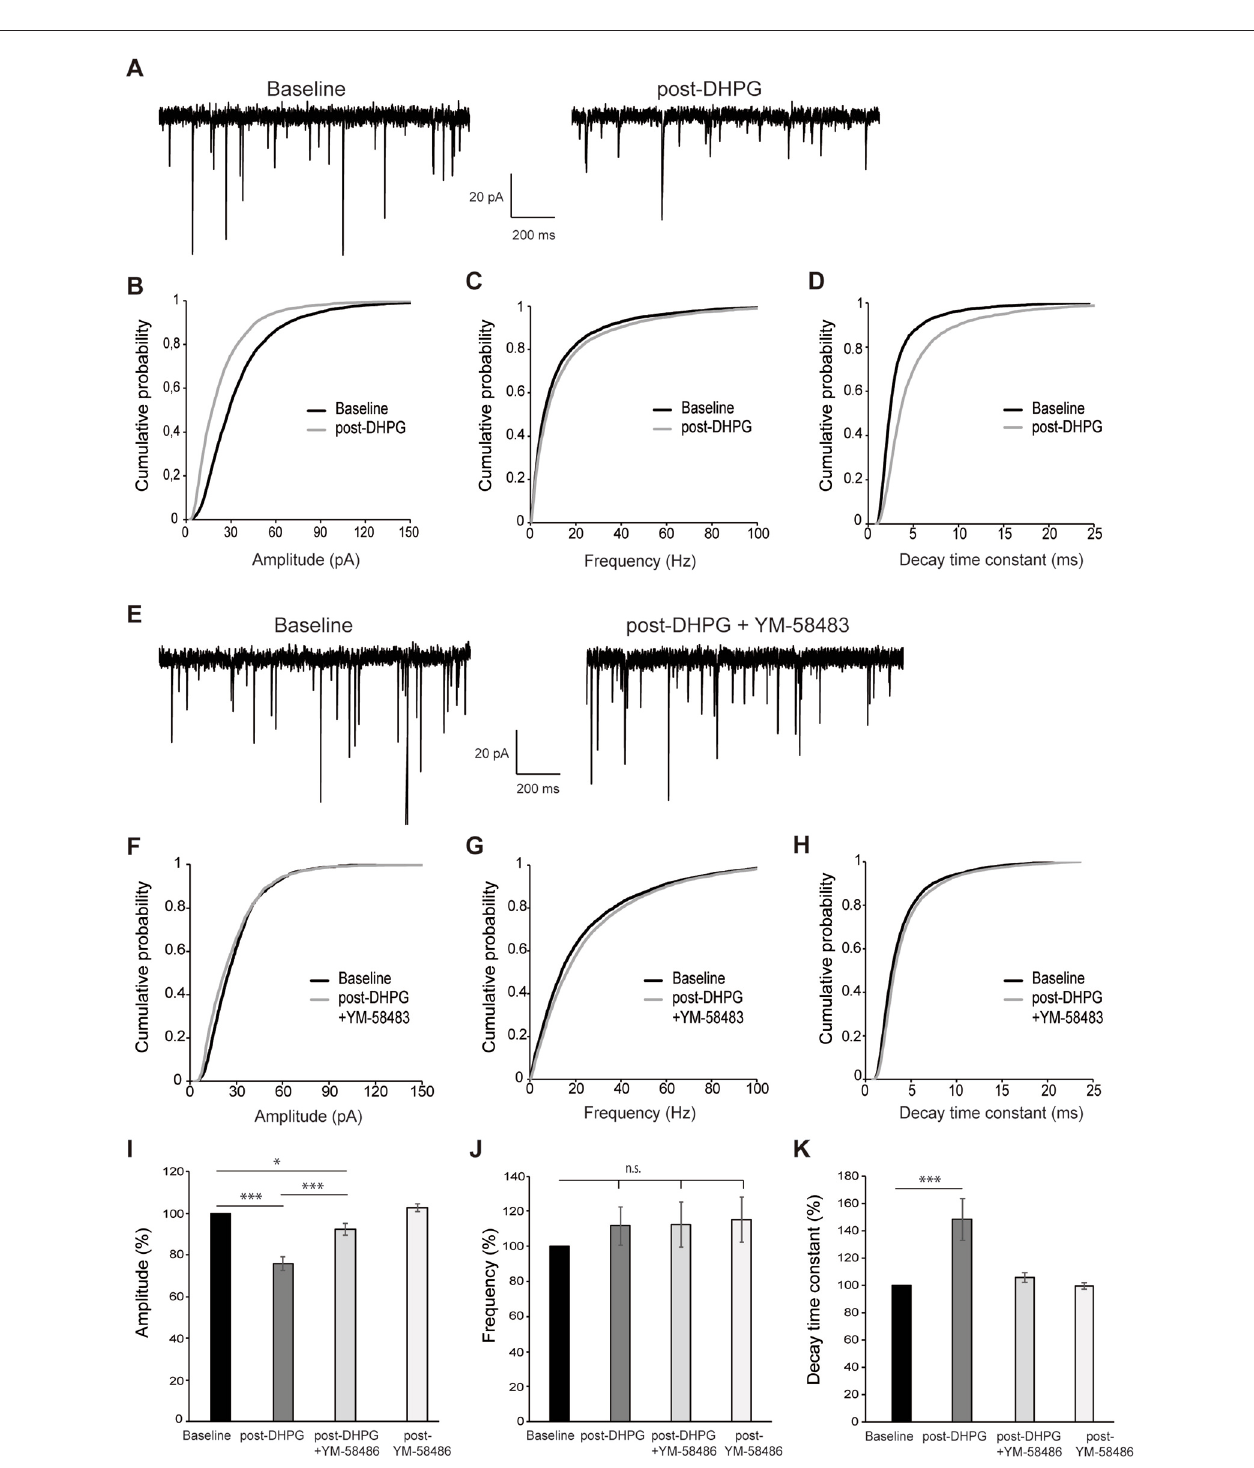
FIGURE 4 | DHPG-long-term depression (LTD) is impaired by SOCE inhibition. (A) Representative miniature excitatory postsynaptic current (mEPSC) recordings from a cortical neuron before (left, “baseline”) and 15 min after 200 µ M DHPG application (right, “post-DHPG”). (B–D) Cumulative probability graphs for amplitude (B) , frequency (C) and decay time constant (D) of mEPSCs, showing baseline (2 min) and a 2 min interval beginning 15 min after DHPG application. (E) Representative mEPSC recordings from a cortical neuron before and 15 min after 200 µ M DHPG + 10 µ M YM-58483 application. (F–H) Cumulative probability graphs for amplitude (F) , frequency (G) and decay time constant (H) of mEPSCs, showing baseline (2 min) and a 2 min interval beginning 15 min after DHPG + YM-58483 application.